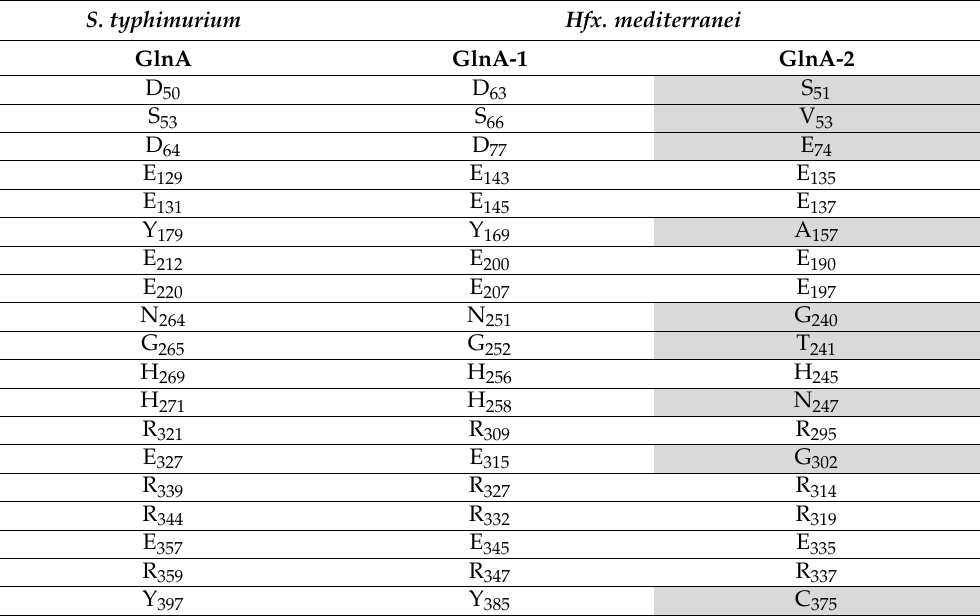
Figure 2. Identification of the conserved residues of Hfx . mediterranei GlnA-1 and GlnA-2 proteins. The adenylylation box is shown marked with a dashed red line. GlnA-St corresponds to the GS protein sequence from S. typhimurium . Table 2. Amino acids related to glutamine synthesis of the different GlnA proteins. The substitutions of the residues are highlighted in